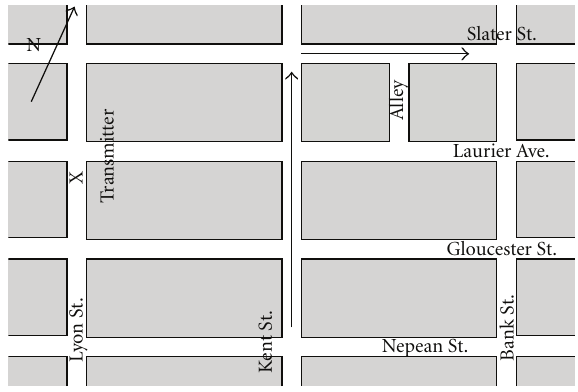
Figure 1: Map of the measurement areas in downtown Ottawa. The arrows indicate the measurement routes, and x marks the transmitter location.